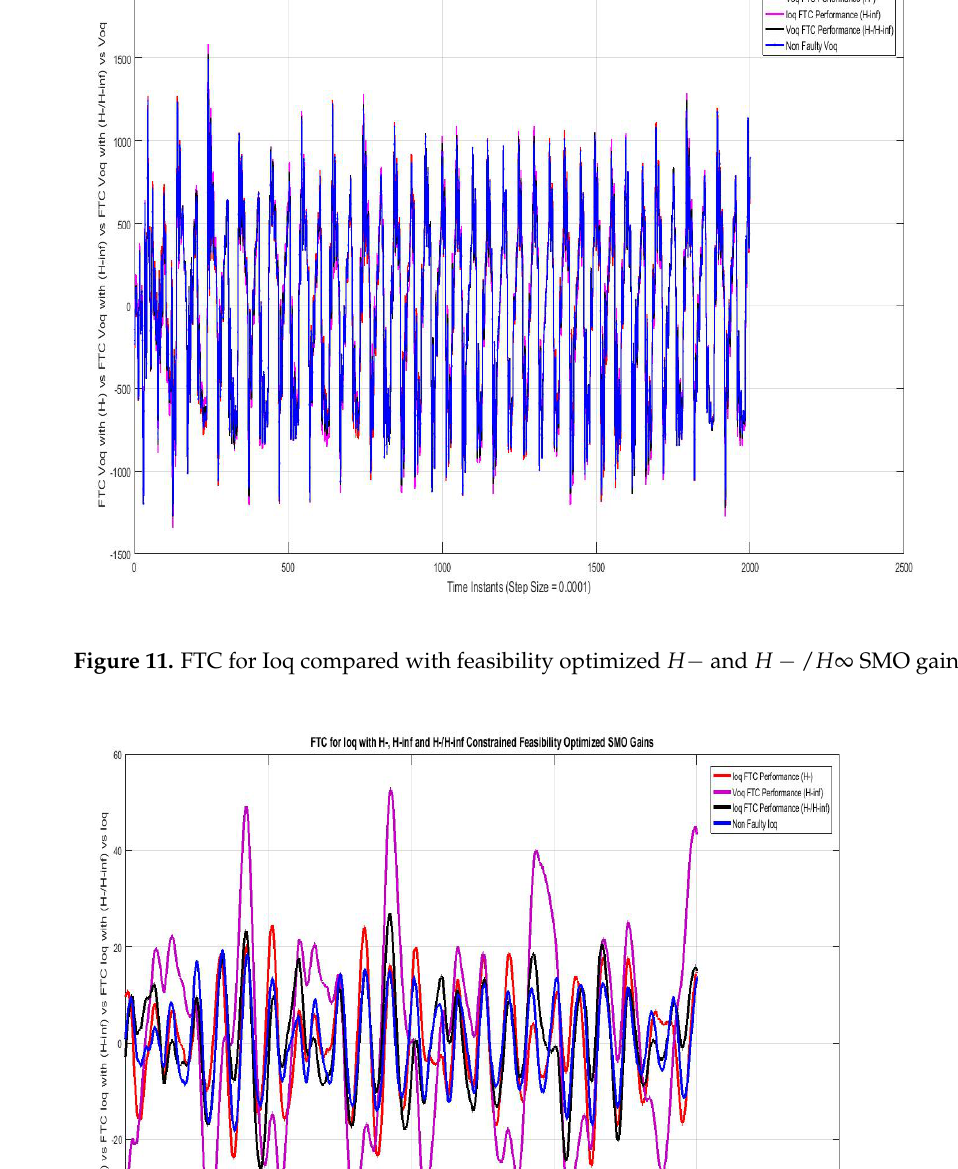
( V ) compared using SMO with gains optimized with fault sensitivity parameter ( H − ) , d robustness to disturbance parameter ( H ∞ ) and a mixed ( H − / H ∞ ) with non-faulty actual V q . The results with all three are comparable and non very differentiating w.r.t each